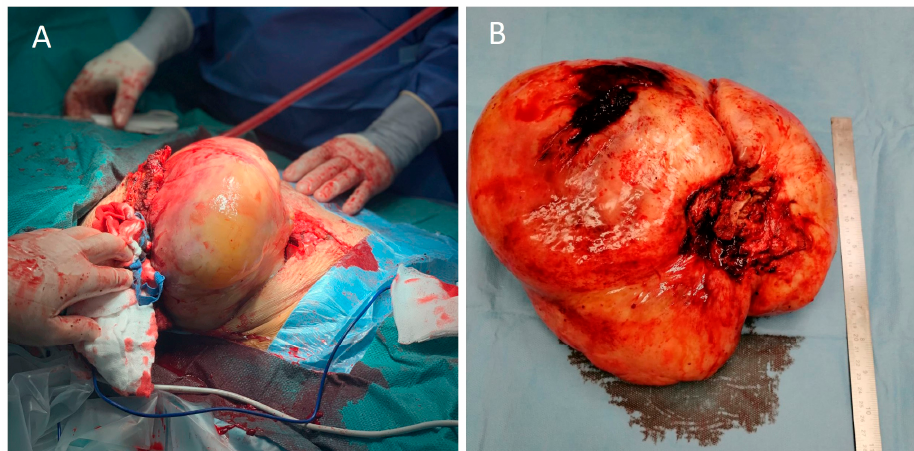
Figure 2. ( A ) Intraoperative image of the resection; ( B ) the resected tumor. At the conclusion of surgery, the patient had received a total of 2000 mL of intravenous fluids and 2 units of pRBC. Urine output was 600 mL over a 4 h period. The patient was hemodynamically stable, and extubation was attempted. Reversal of neuromuscular blockade was achieved with intravenous sugammadex 2 mg/kg. During awakening, the patient became hypoxic while still intubated and secretions filled the endotracheal tube. Auscultation revealed diffuse moist rales of the right lung. Suctioning of the right lung was copious, and 400 mL of serous fluid was collected (Figure 3A). Re-expansion pulmonary edema was suspected, and the patient was sedated again. The two-lumen tube was exchanged with a single lumen tube, and the patient was transferred to the intensive care unit (ICU) for postoperative mechanical ventilation. Chest X-ray at the ICU revealed diffuse alveolar infiltrates of the right lung (Figure 3B). The patient remained sedated for 24 h post-operatively where she was treated with continuous positive pressure ventilation and administration of corticosteroids (cortisol 50 mg, 4/day, reduced to twice/day on the improved significantly, and she was successfully extubated after 30 h post-surgery and treated with non-invasive ventilation for 2 more days. She remained in the ward for 5 more days and was discharged from the hospital with no further complications. Postoperative histological examination of the mass confirmed the diagnosis of a desmoid tumor. Surgical excision margins were clear of tumor cells.